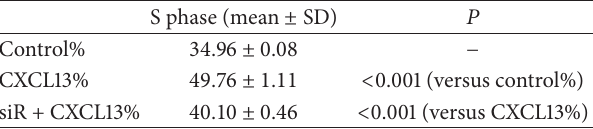
Table 2: Ratio of cells in S phase from different